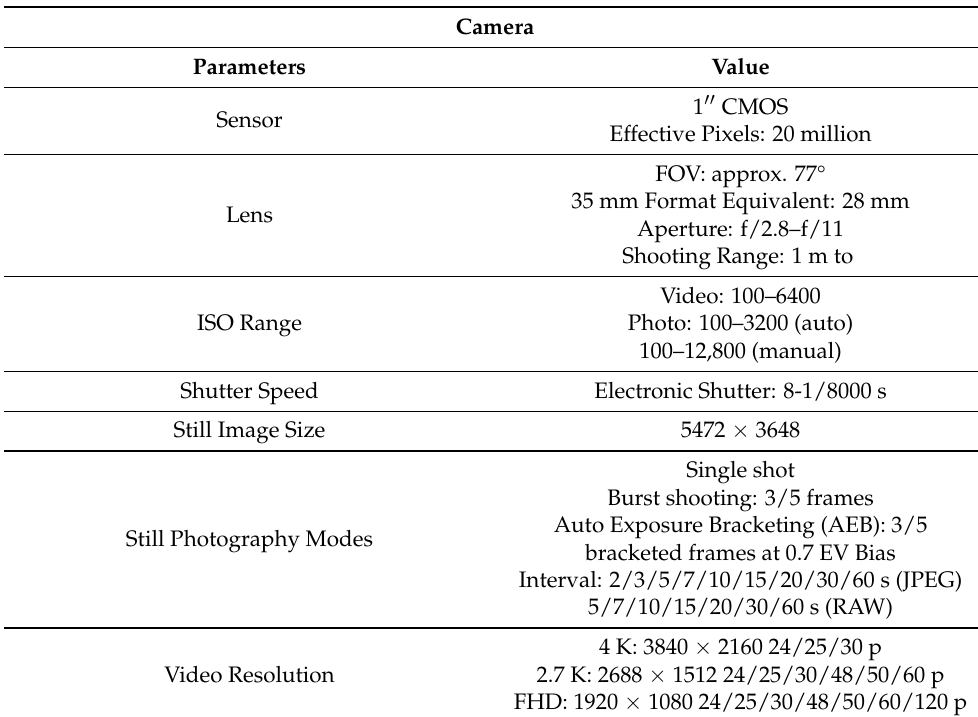
Table A10. The configuration of the attached